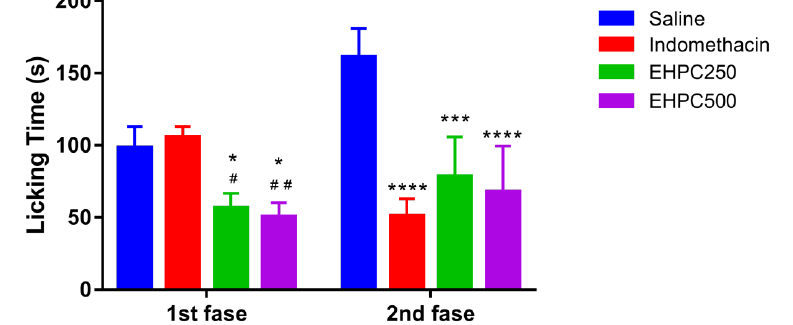
Figure 5. Formalin test induced by subplantar administration of 2.5% formalin in mice treated orally with 0.9% NaCl, indomethacin 10 mg/kg, EHPC 250 and 500 mg/kg. * p < 0.05; *** p < 0.01; **** p < 0.001 vs. NaCl; # p < 0.05; ## p < 0.005 vs Indomethacin (ANOVA; Tukey).